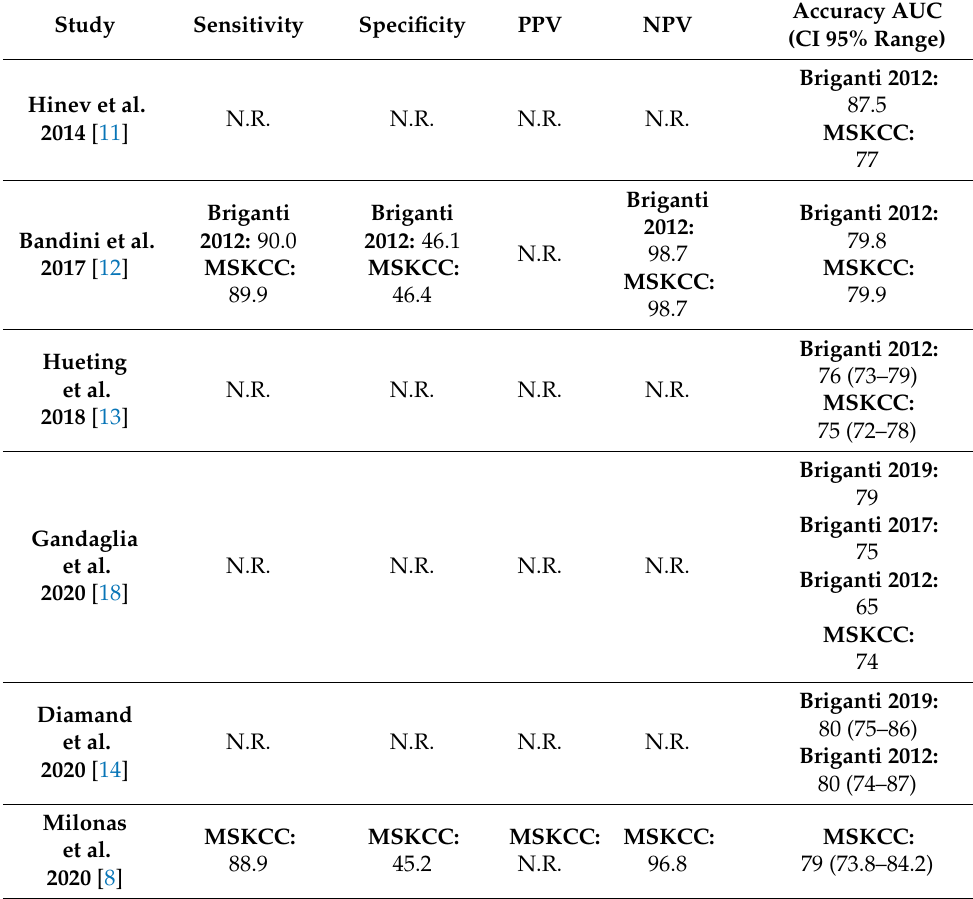
Table 6. Studies investigating the accuracy of most frequently used nomograms to predict the probability of lymph node metastases before radical